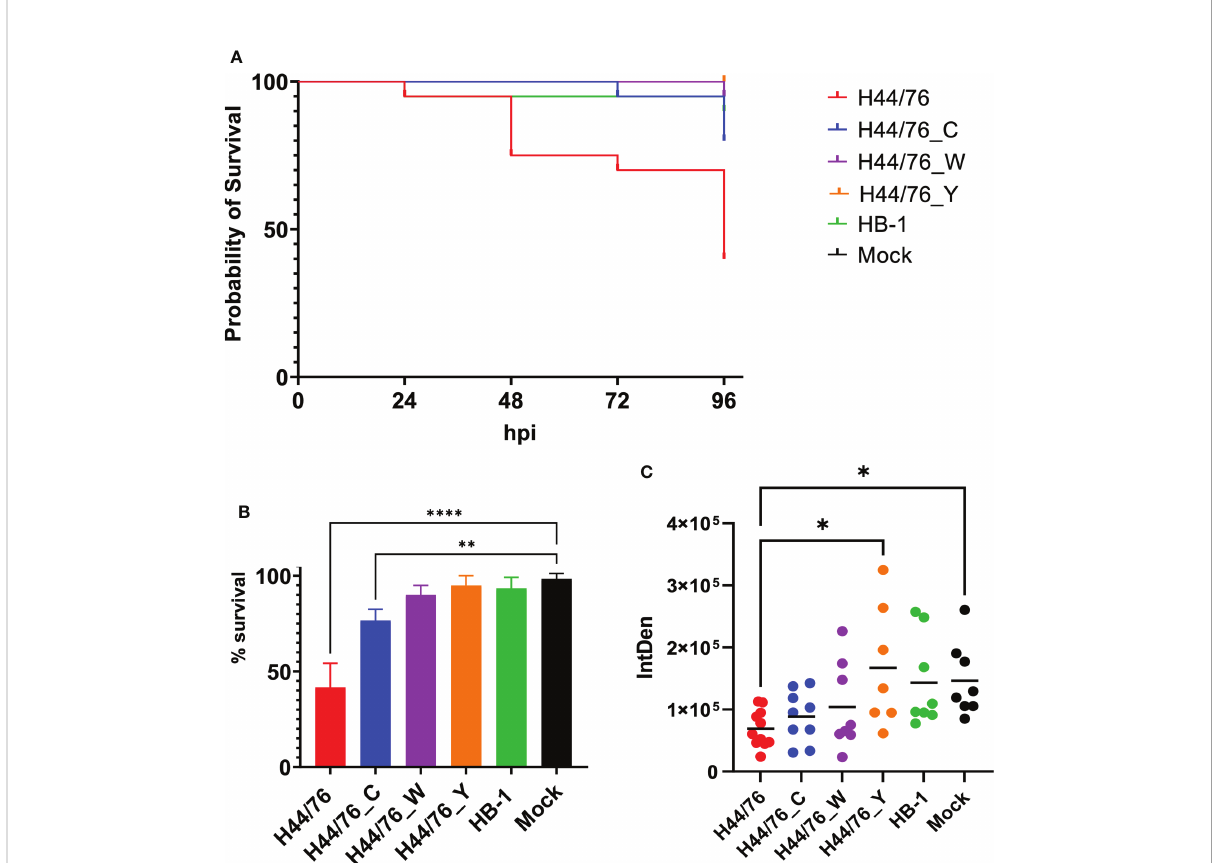
FIGURE 5 (A) Survival curve of zebra fi sh embryos infected with H44/76 expressing serogroup B capsule (1560 cfu), no capsule (HB-1) (3600 cfu), serogroup C capsule (H44/76_C) (1200 cfu), serogroup W capsule (H44/76_W) (3600 cfu) or serogroup Y capsule (H44/76_Y) (4800 cfu) all expressing mCherry 20 embryos in each group. (B) Survival of zebra fi sh embryos infected with H44/76 expressing serogroup B capsule (2700 ± 1820 cfu), no capsule (HB-1) (1960 ± 1420 cfu), serogroup C capsule (H44/76_C) (2160 ± 1660 cfu), serogroup W capsule (H44/76_W) (2760 ± 840 cfu) or serogroup Y capsule (H44/76_Y) (2720 ± 1817 cfu) scored at 96hpi. Three independent experiments, 20 embryos in each group. (C) Quanti fi cation of GFP-expressing neutrophils in zebra fi sh embryos 24 hpi with N. meningitidis H44/76_B (1400 cfu), HB-1 (1600 cfu),